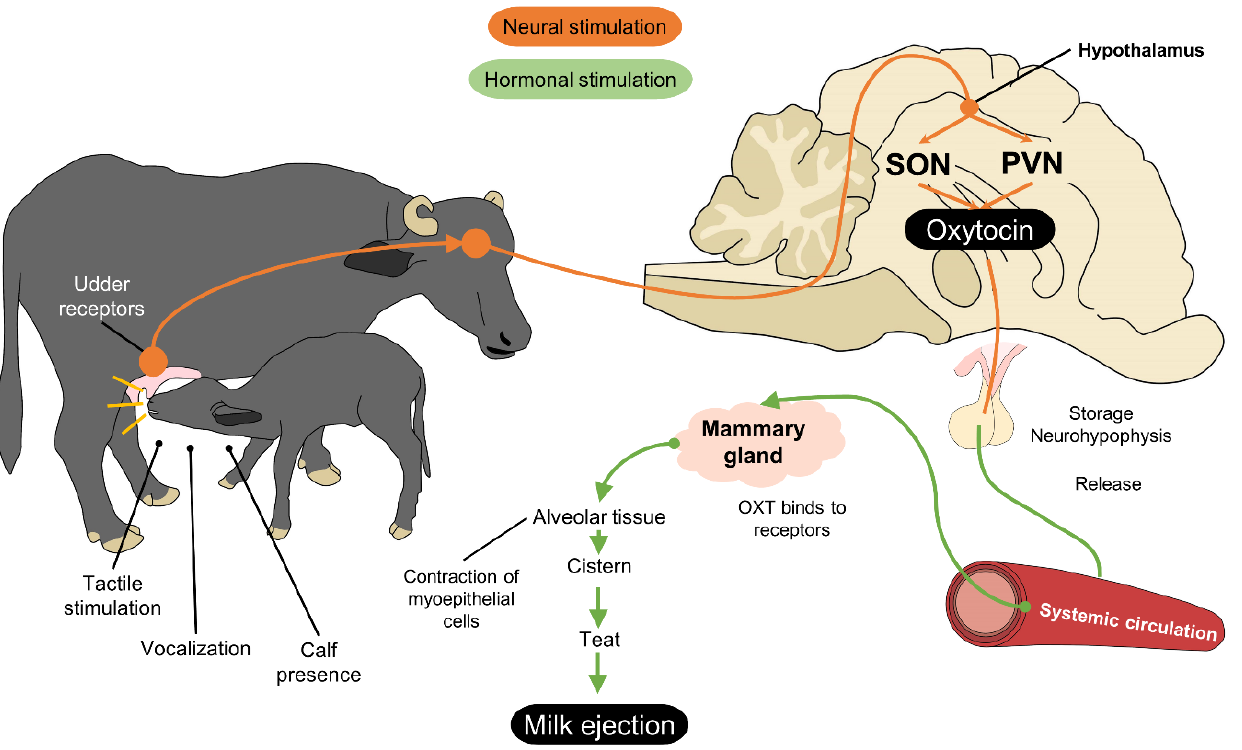
Figure 11. The role of oxytocin (OXT) and suckling behavior. Buffaloes require the presence of the calf and tactile, auditory, and olfactory stimuli for the neural and hormonal stimulation of milk release. The neural pathway begins in receptors located in the udder that are stimulated by the newborn. This stimulus is carried to brain nuclei in the hypothalamus, specifically the SON and PVN, which are responsible for producing OXT. Subsequently, the OXT produced is stored in the neurohypophysis, ready to be secreted into the bloodstream when maternal stimuli are perceived. Once in the mammary gland, OXT binds to specialized receptors in the alveolar tissue, causing contraction of the myoepithelial cells. This allows the milk to pass from the alveolar tissue into the cistern and teat. Finally, milk is ejected in a cycle in which the calf plays a key role essential. PVN: paraventricular nucleus of the hypothalamus; SON: supraoptic nucleus of the